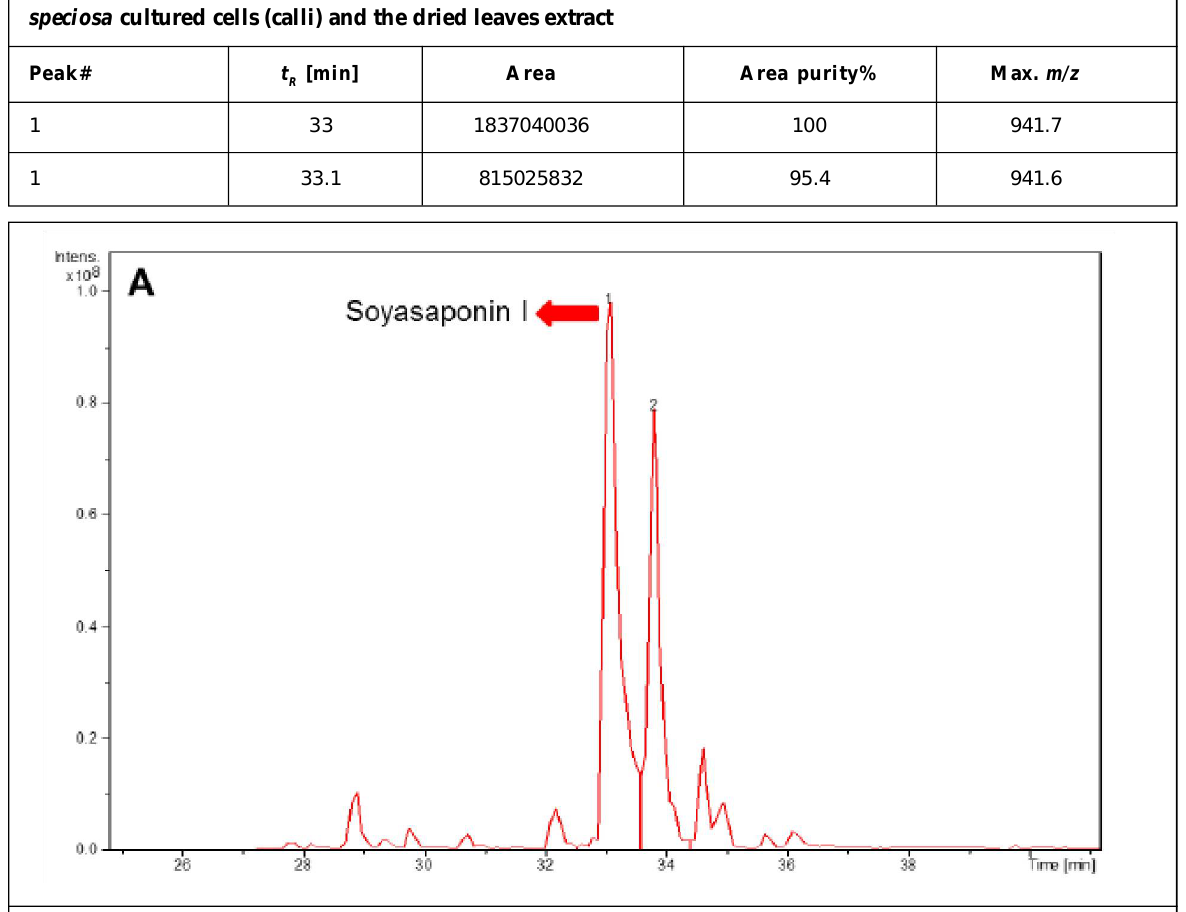
Figure 3. HPLC analysis of (A) the n -butanolic fraction of T. speciosa Benth cultured cells (B) the n -butanolic fraction of T. speciosa Benth dried leaves extract. Peak 1 is the peak of